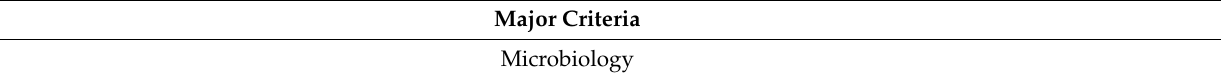
Table 1. European Society of Cardiology 2015 modified criteria for the diagnosis of infective